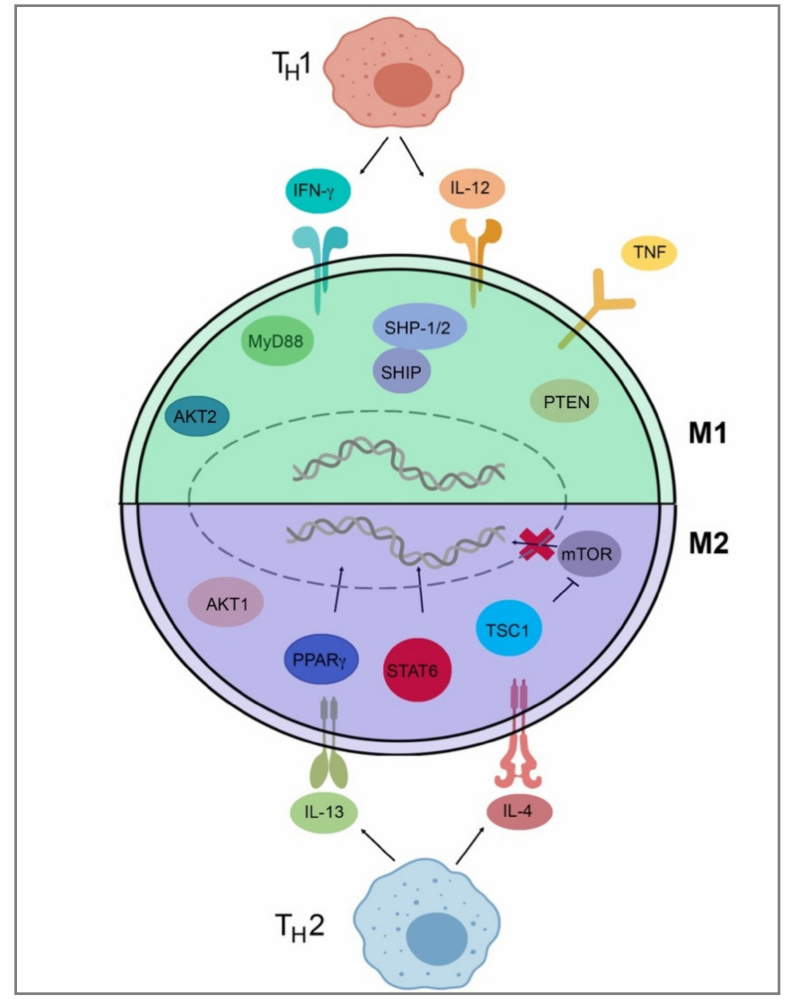
Figure 2. Signal pathways of macrophage polarization. This figure illustrates several of the various mechanisms that drive extrinsic macrophage polarization. Those pathways include IFN-y and IL- 12 secretion by TH1 T-cells, LPS signaling through mTOR/Akt or TLR4, Akt2/NF- κ B activation, SHP-1/2 inhibition of Cd11b, SHIP and MyD88 inhibition of M2 genes, PTEN activation, and TNF/TNFR/NF- κ B activation to induce M1 gene expression. Induction of M2 genes is directed by the secretion of IL-4 and IL-13 from TH2 T-cells and IL-4R α receptor activation as well as downstream Stat6-dependent arginase-1 inhibition, PPAR γ activation, and TSC1 inhibition of mTOR. This figure was created with Biorender.com (accessed on 1 May